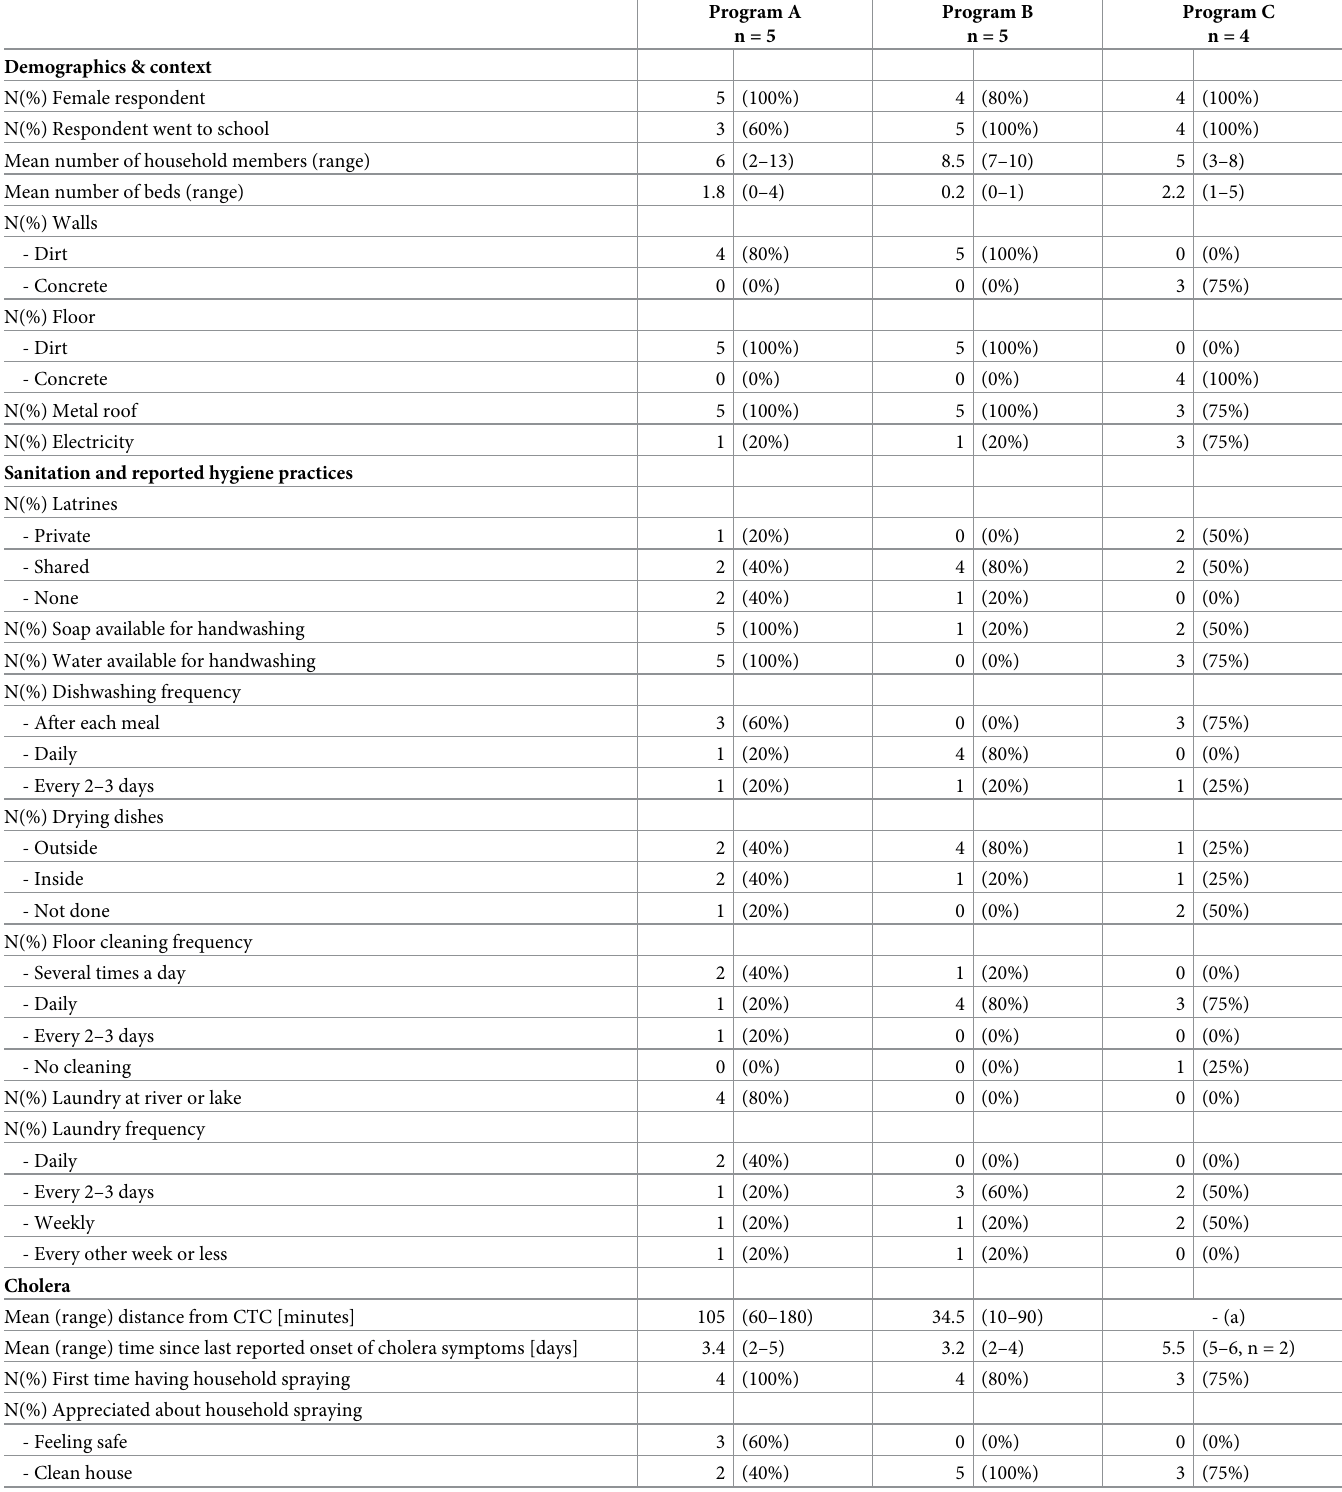
Table 2. Selected household survey